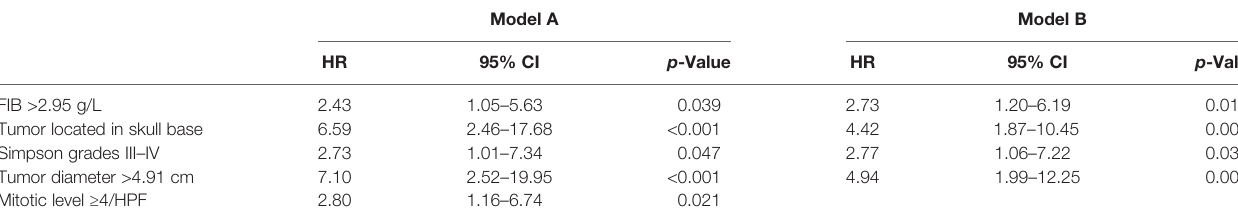
TABLE 4 | The composition of two models based on lasso regression